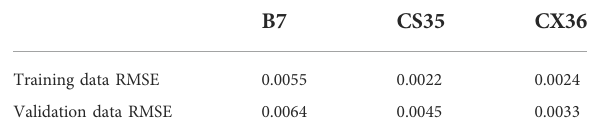
TABLE 2 Training performance of the